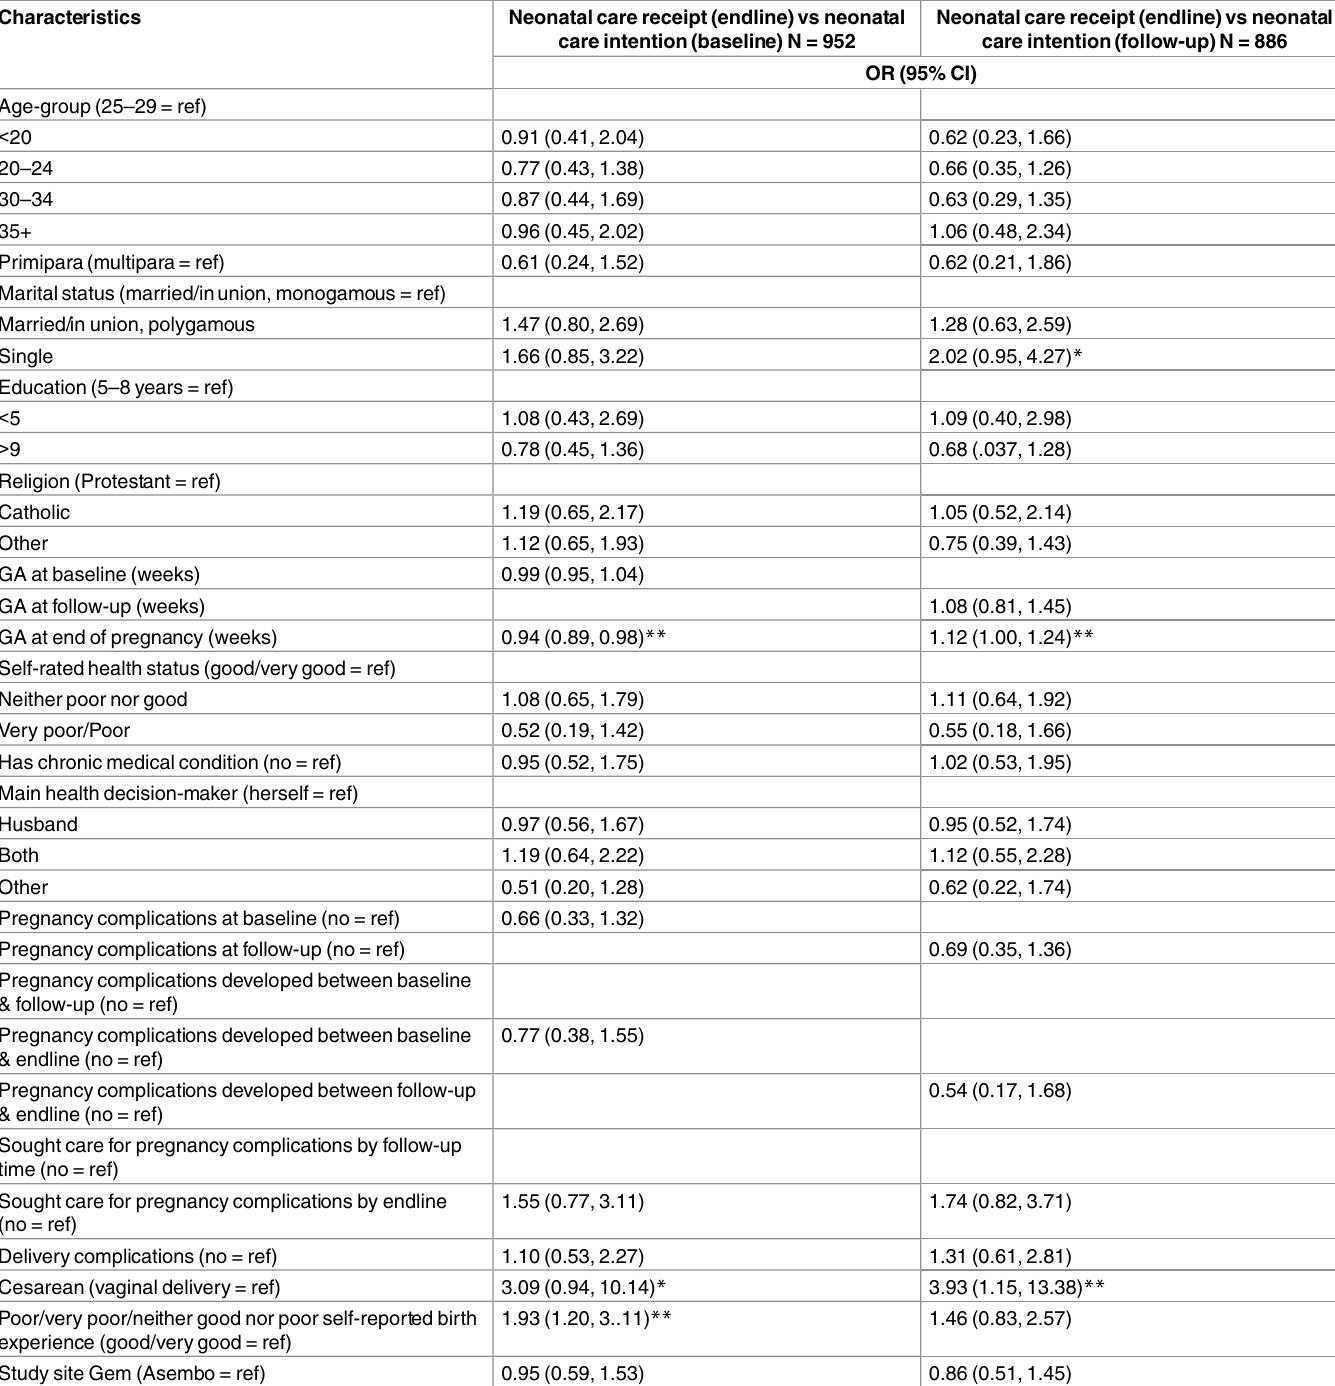
Table 4. Predictorsof discordance betweenwomen’s intentionsand behaviors regardingneonatal care:Kenya, 2013.